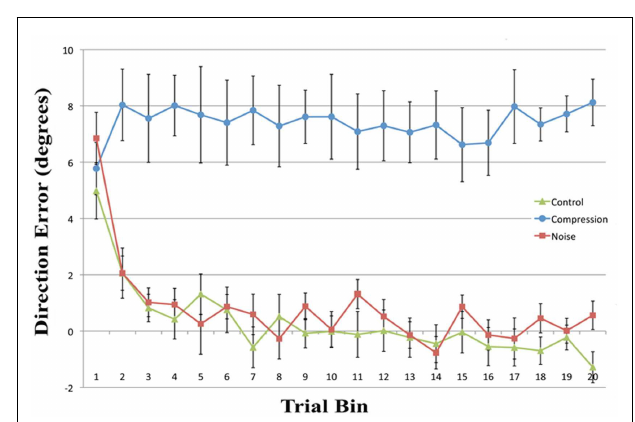
FIGURE 2 | Mean directional pointing error (with SE bars) for each two-trial bin in the prism-adaptation phase for all three conditions . Positive values indicate a rightwars error in the direction of the prism